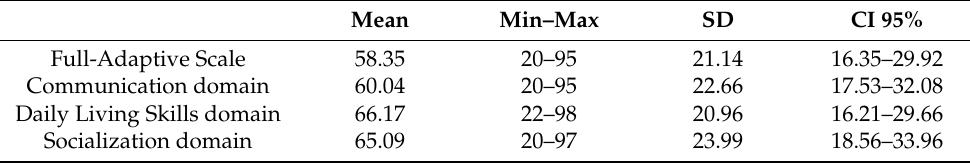
Table 4. Adaptive behaviour of children and adolescents with KBG